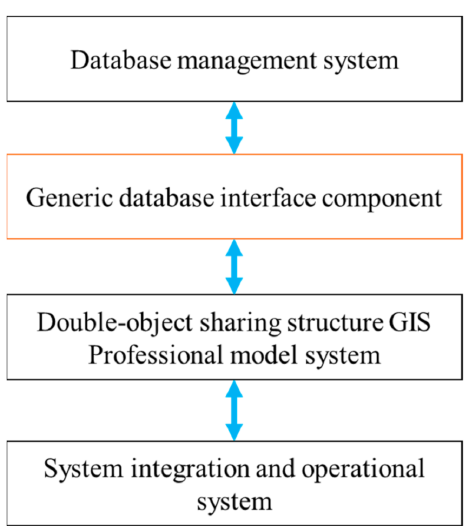
Figure 5. The information flow of